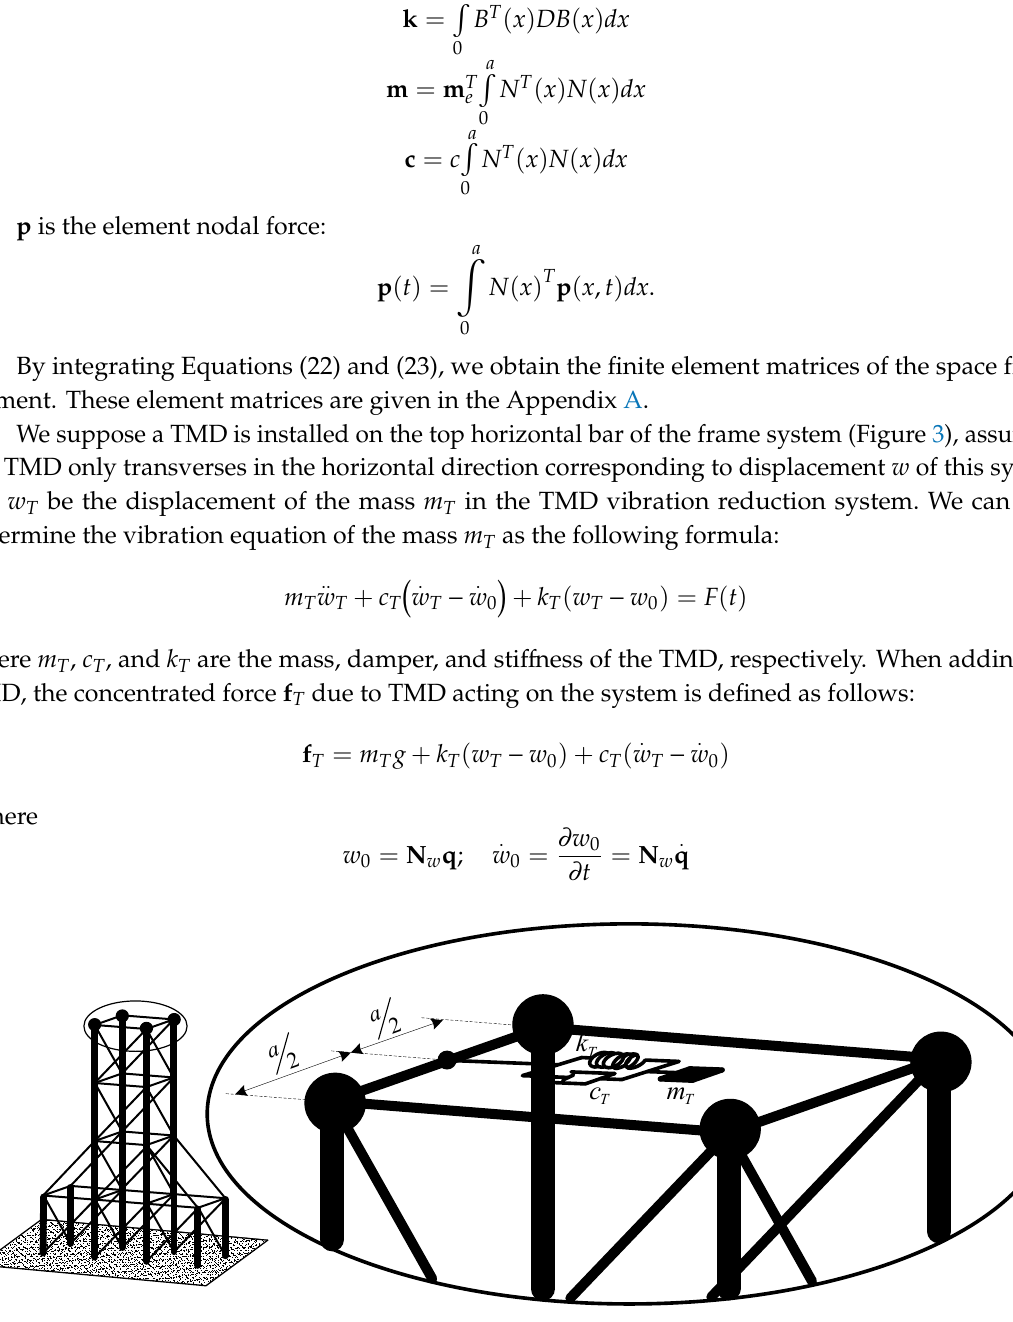
Figure 3. The real space frame system with a tuned mass damper (TMD).